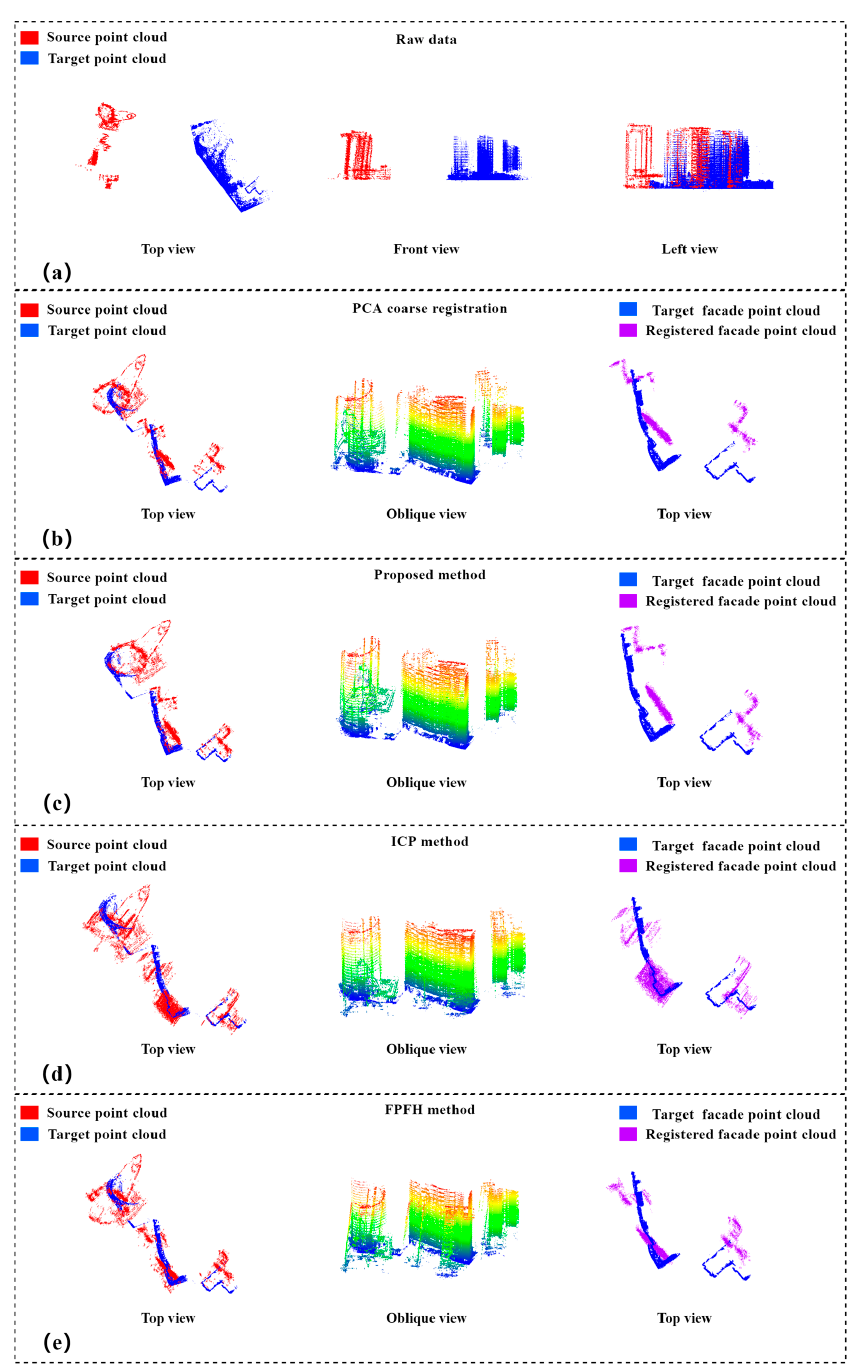
Figure 12. Experiment 3 alignment results of cross-source TomoSAR point cloud with MLS point cloud: ( a ) top, front, and left views of the original data; ( b ) top and oblique views of the coarse alignment results based on PCA and top view of the aligned facade points; ( c ) top and oblique views of the alignment results of this paper and top view of the aligned facade points; ( d ) top and oblique views of the alignment result of ICP algorithm and top view of the facade point after alignment; ( e ) top and oblique views of the alignment results of FPFH algorithm and top view of the aligned facade